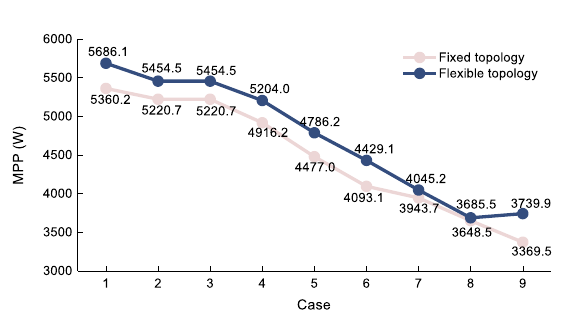
Fig. 16 MPPs of the SP-based PV array for the 9 cases in Scenario 5